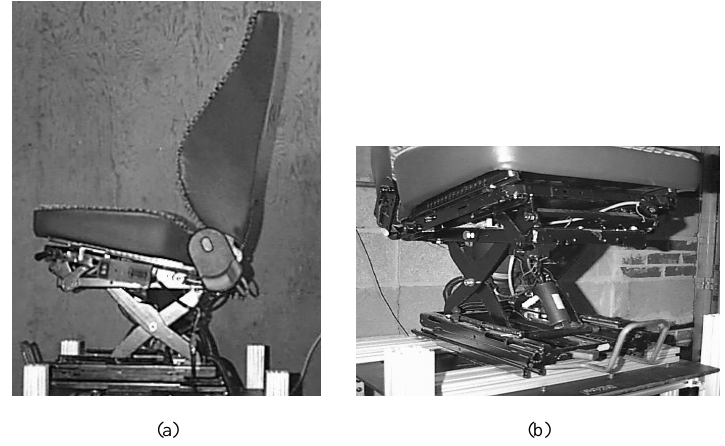
Fig. 3. Base-Excited Single Degree of Freedom System (SDOF) test